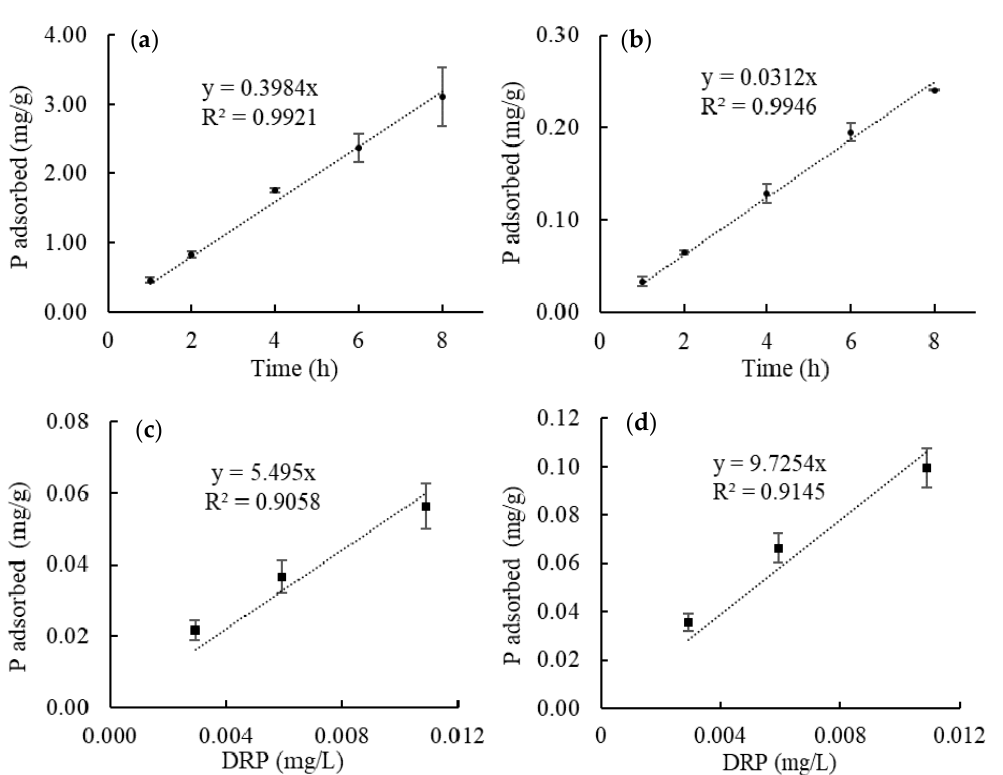
Figure 7. Laboratory calibration experiments using ( a ) HR1 and ( b ) HR2. The dashed lines show the linear fitting of the amount of P adsorbed with different adsorption time. Laboratory sampling rate, R L , for HR1 and HR2 is calculated to be 0.1992 and 0.0156 L/h, accordingly. ( c , d ) Shows the result of field calibration experiments using HR1 and HR2, respectively. The dashed lines show the linear fitting of the amount of P adsorbed with the DRP concentration of the tile water. Field sampling rate, R F , for HR1 and HR2, is 0.0763 and 0.1351 L/h, respectively.